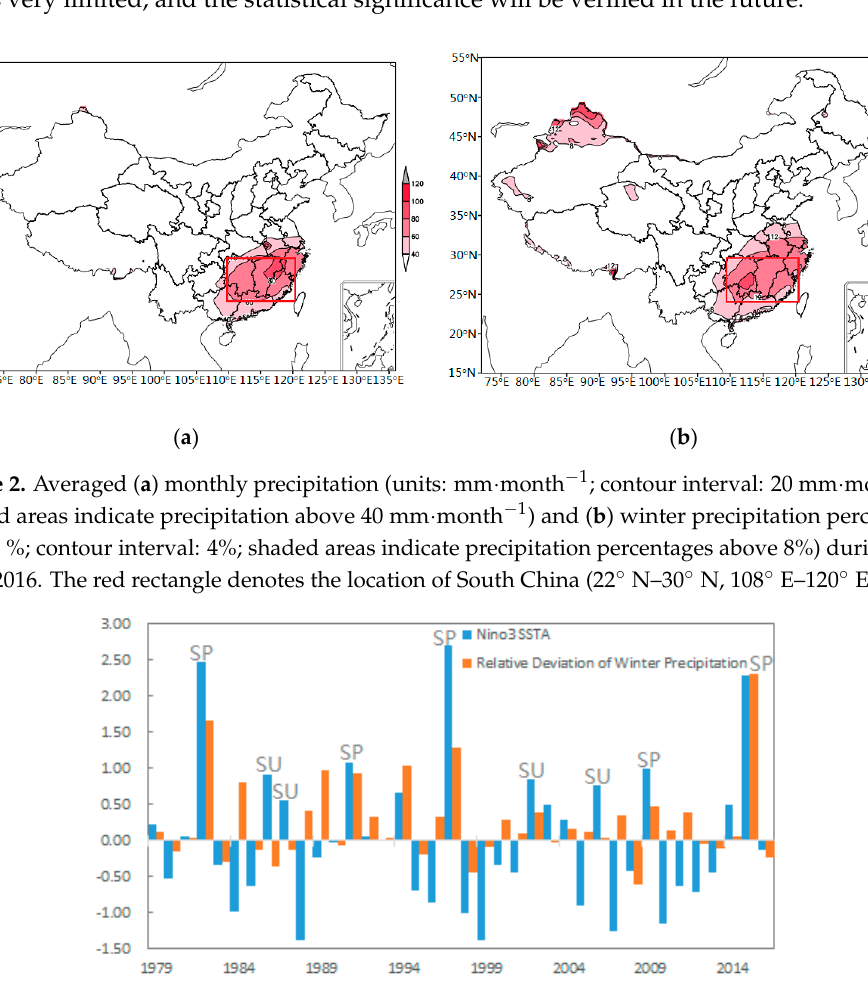
Figure 3. Temporal evolution of the Niño3 SST anomaly (blue; units: °C) and relative deviation of winter precipitation (orange) over South China during DJF 1979–2016. The relative deviation of winter precipitation equals the absolute deviation divided by the arithmetic mean of winter precipitation (during 1961–2016). Positive values indicate greater than mean precipitation, and negative values indicate less than mean